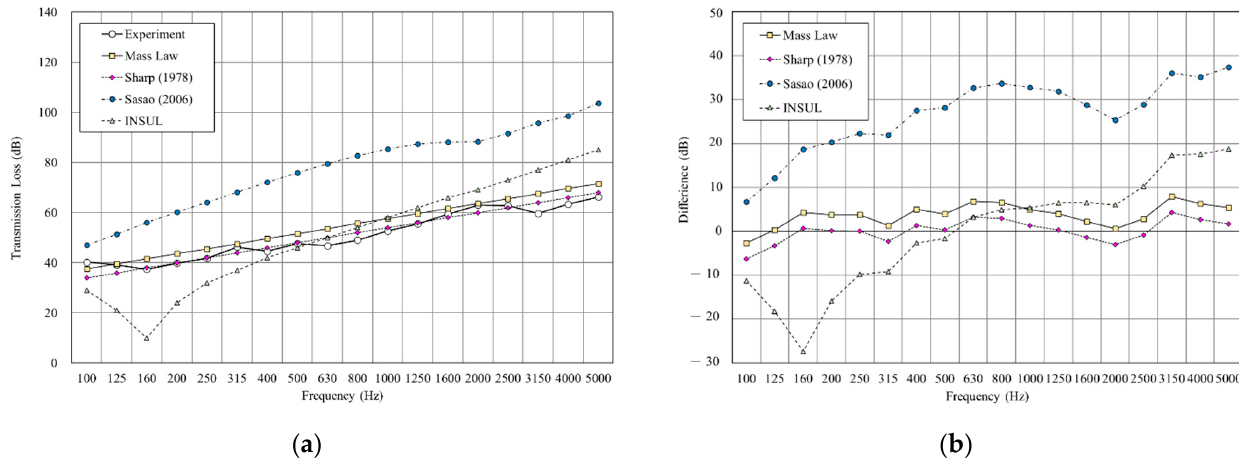
Figure 15. Comparison between experimental and predicted results of the double wall with 25 mm glass wool in 75 mm cavity (B7). ( a ) The sound insulation performance of experiment and prediction. ( b ) The RMSE results of different prediction models.